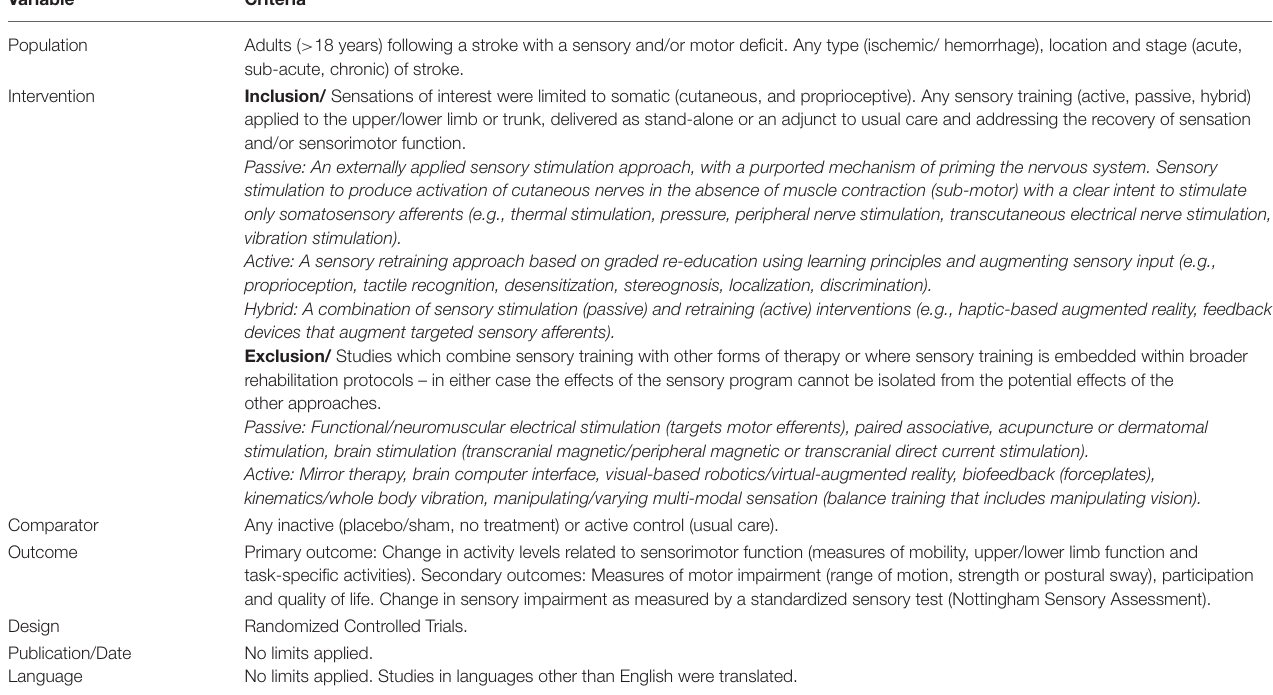
TABLE 1 | Search criteria. Variable